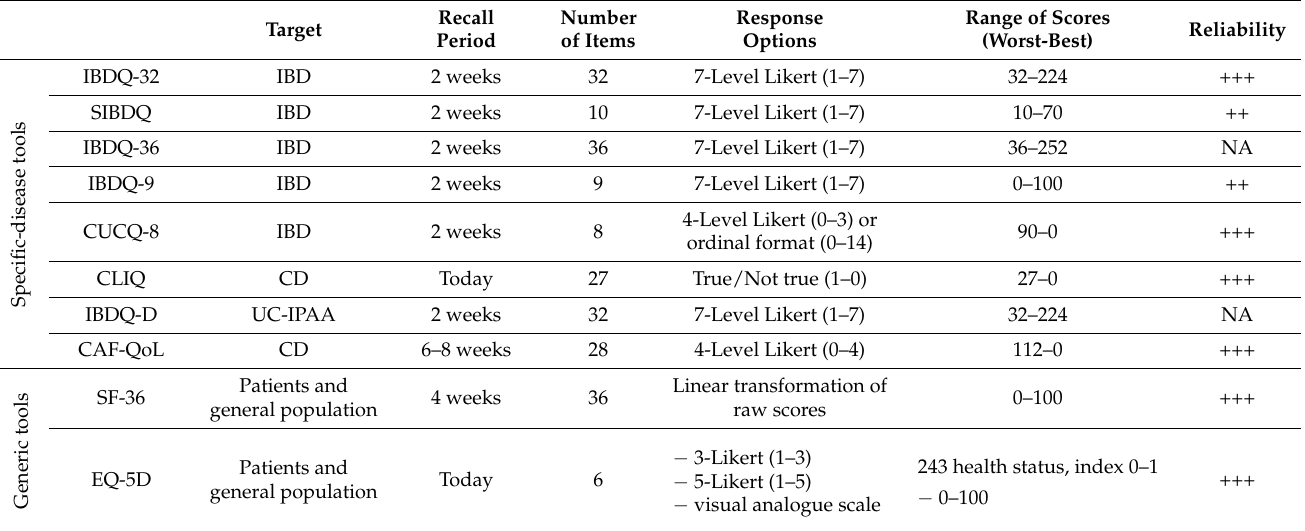
Table 1. Characteristics of tools for measure HRQoL in